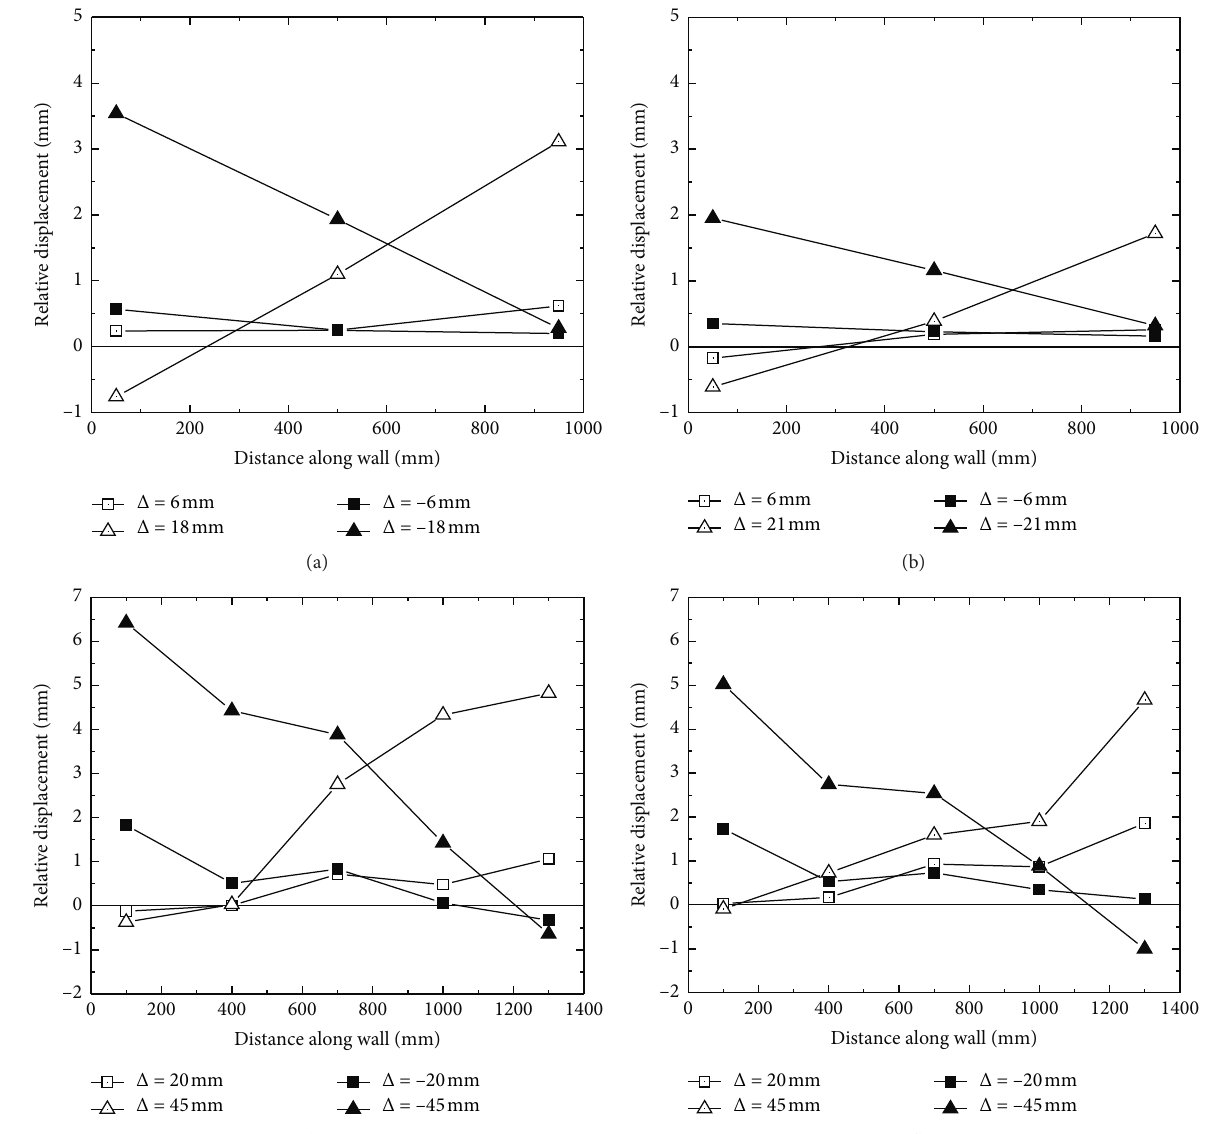
Figure 13: Vertical relative displacement of wall-to-foundation area along the PC wall length. (a) SRCSW1-1. (b) SRCSW1-2. (c) SRCSW2- 1. (d)